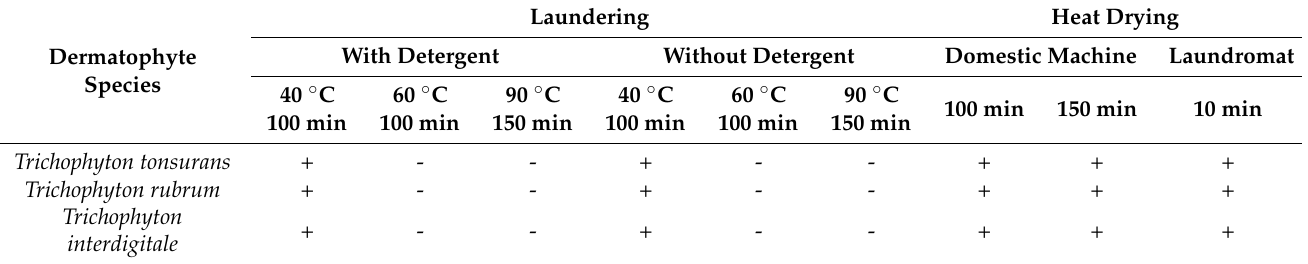
Table 1. Viability of cells/conidia of three Trichophyton species on previously contaminated gauze pads after laundering or heat drying at diverse temperatures and